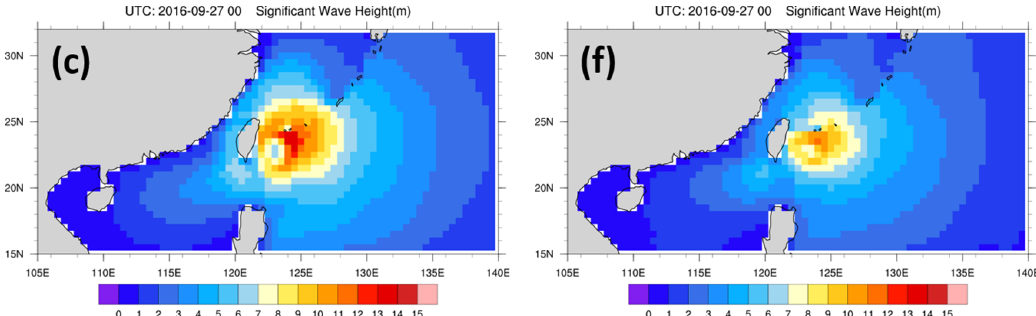
Figure 2. Spatial distribution of significant wave height driven by the CFSv2 ( a – c ) and the ERA5 ( d – f ) winds; a WW3 model with a 0.50 deg grid resolution was used for Typhoons Meranti ( a , d ), Malakas ( b , e ), and Megi ( c , f ).